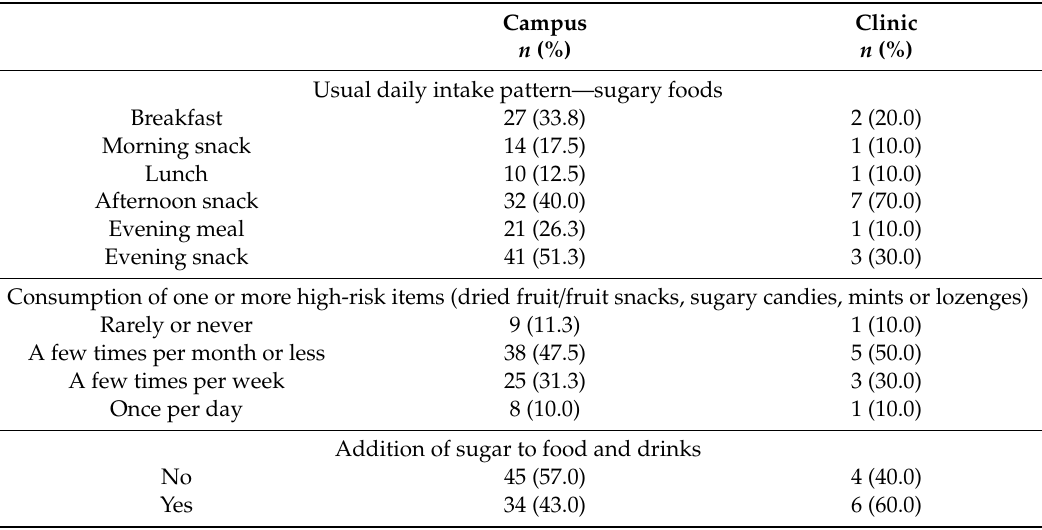
Table 2. Sugar consumption behaviours among participants in the Campus and Clinic groups. Campus n (%)